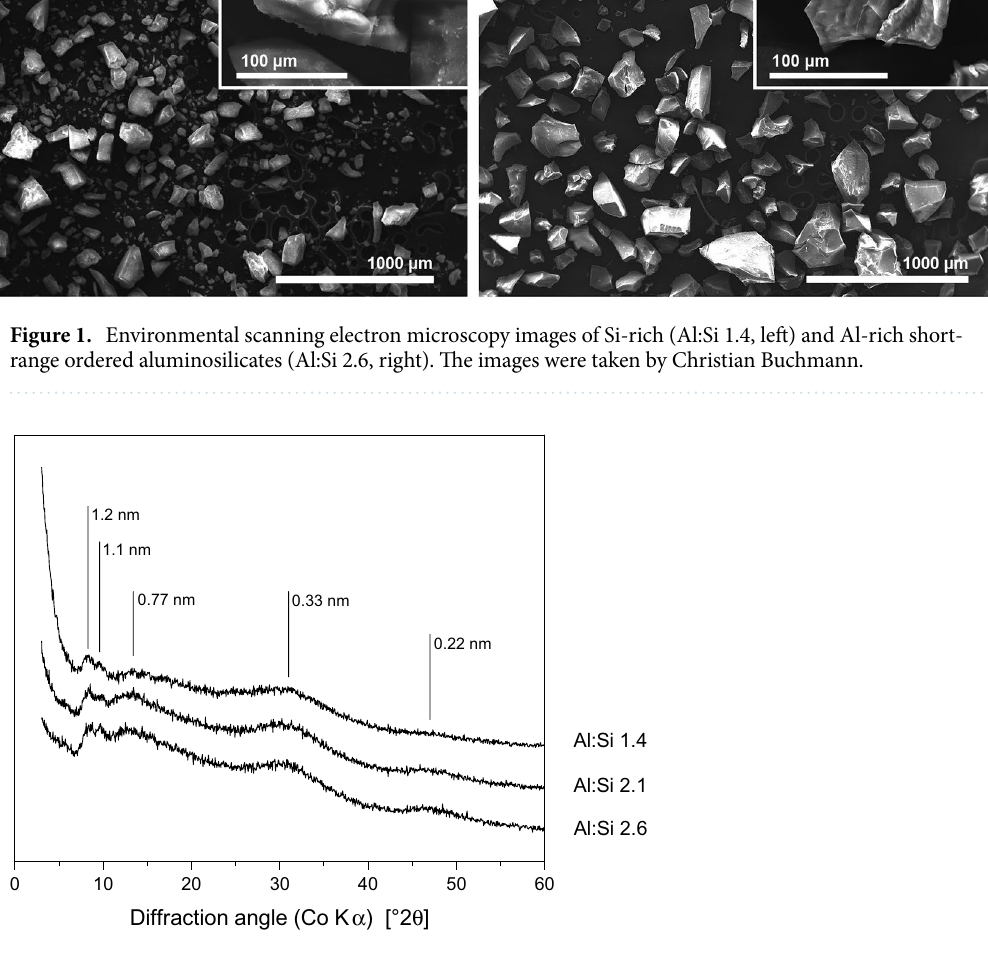
Figure 2. X-ray diffractograms of short-range ordered aluminosilicates. Data is shifted along the y-axis for clarity and given in arbitrary